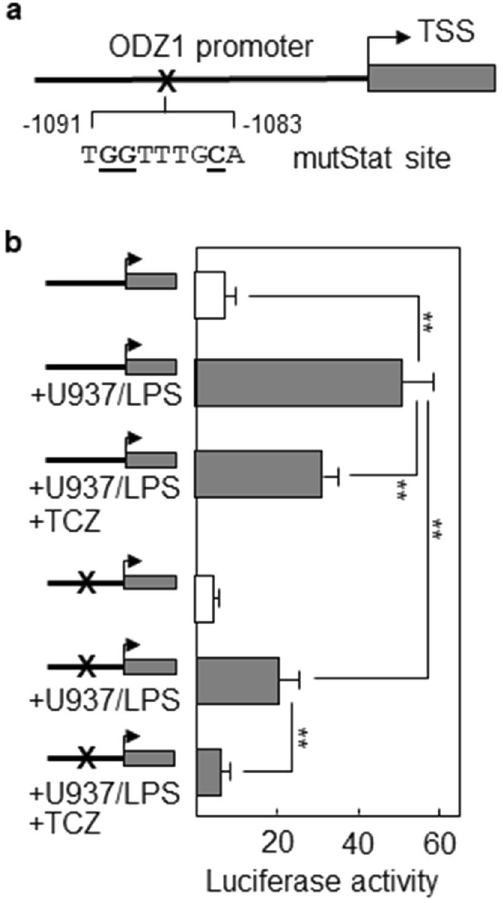
Figure 6. ODZ1 promoter responds to Stat3-activating stimuli. ( a ) Schematic representation of ODZ1 promoter, indicating the nucleotides within the Stat site changed (bold and underlined) by site-directed mutagenesis. ( b ) Wild type or mutant ODZ1 promoter were introduced into GBM cells and response of the promoter to the presence of activated U937 cells with or without Tocilizumab (TCZ) was determined by analyzing luciferase activity. Histograms represent the mean of three independent experiments ± S.D. **p <